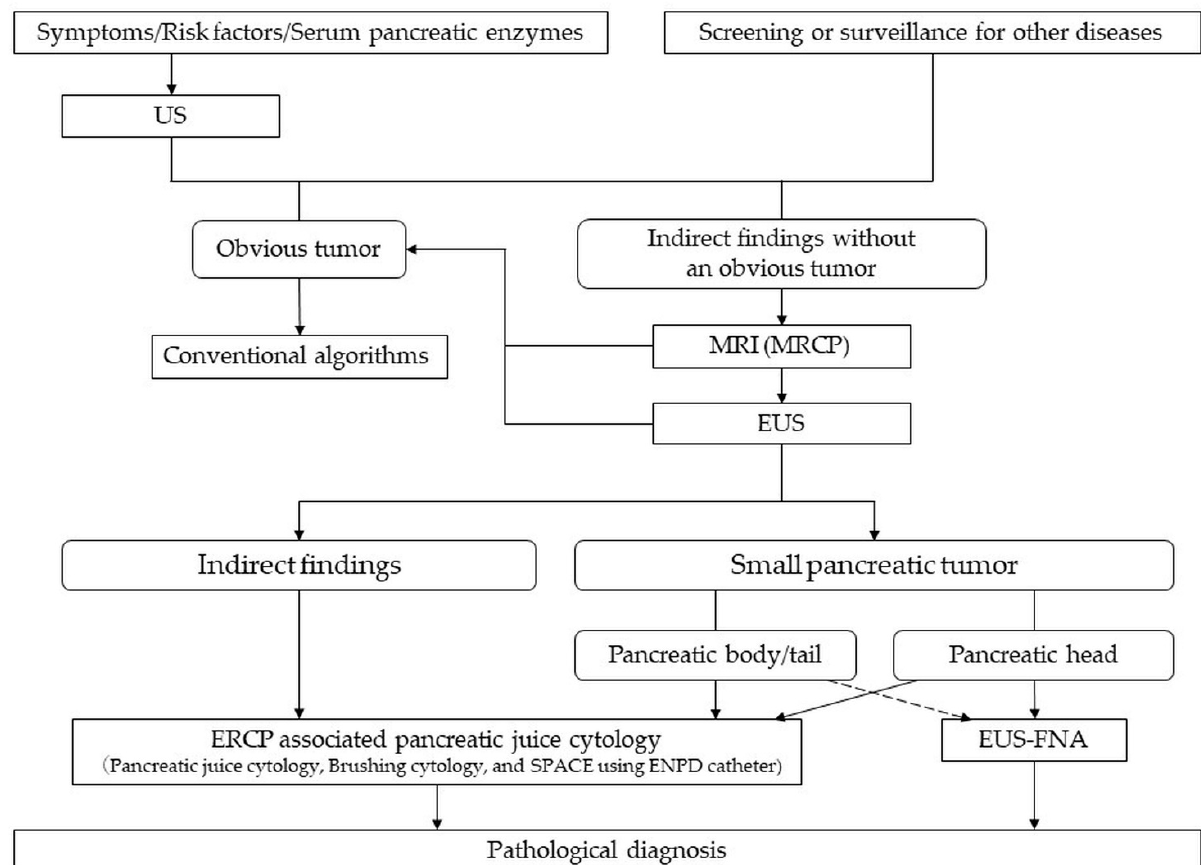
Figure 3. Algorithm for early diagnosis of PDAC at stage 0 and IA with promising long-term prognosis. US, ultrasonography; MRI, magnetic resonance imaging; MRCP, magnetic resonance cholangiopancreatography; EUS, endoscopic ultrasonography; CT, computed tomography; MPD, main pancreatic duct; ERCP, endoscopic retrograde cholangiopancreatography; SPACE, serial pancreatic juice aspiration cytologic examination; ENPD, endoscopic nasopancreatic drainage; EUS-FNA, EUS-guided fine-needle aspiration.